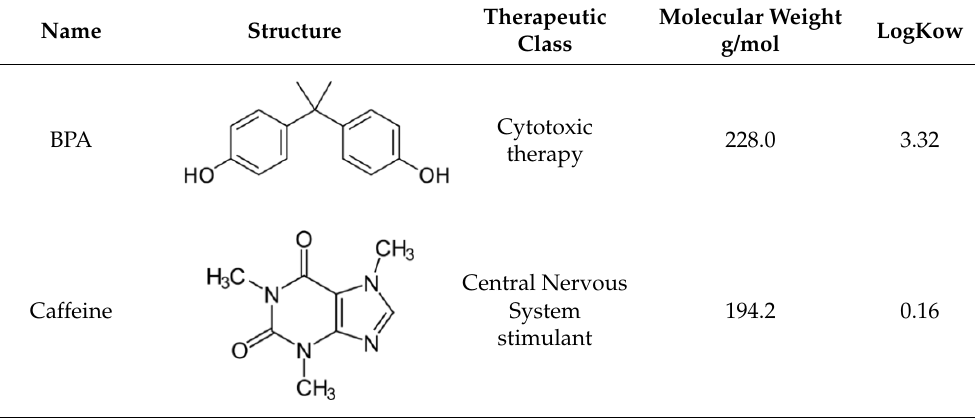
Table 1. Characteristics of model organic micropollutant used as EDC [7,27,28].